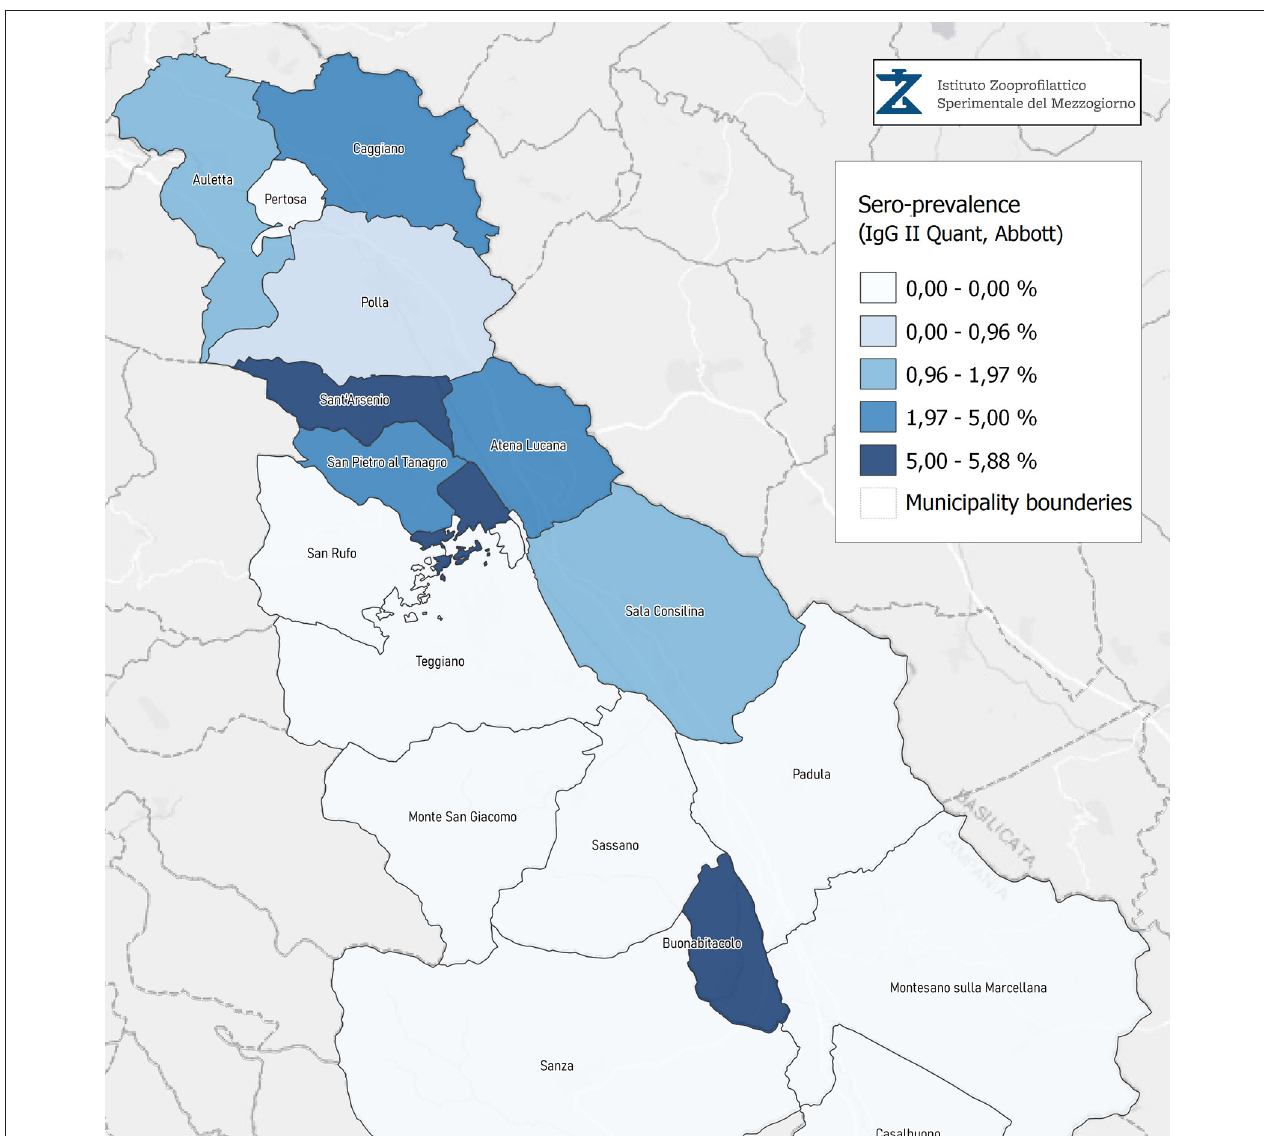
FIGURE 2 | Seroprevalence assessed in Diano Valley municipalities by IgG II Quant